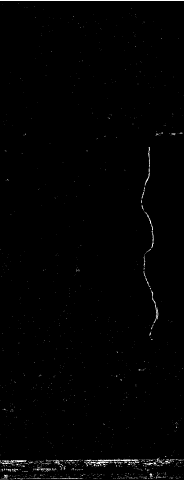
Figure 13. Change map fusion by majority voting.